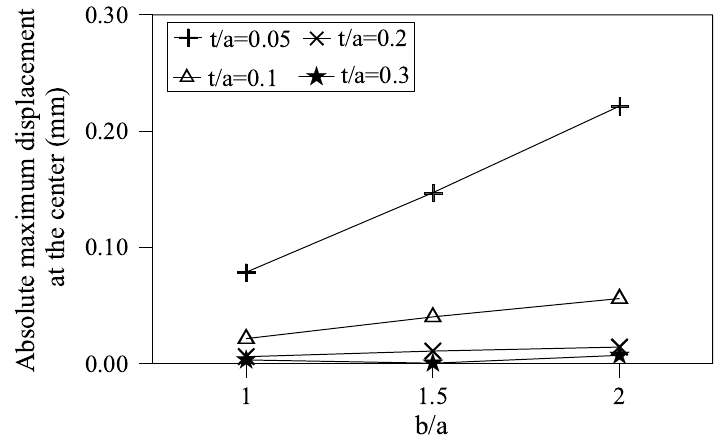
Fig. 7. Absolute maximum displacement of the thick simply supported plates for different aspect ratios and thickness/span ratios.